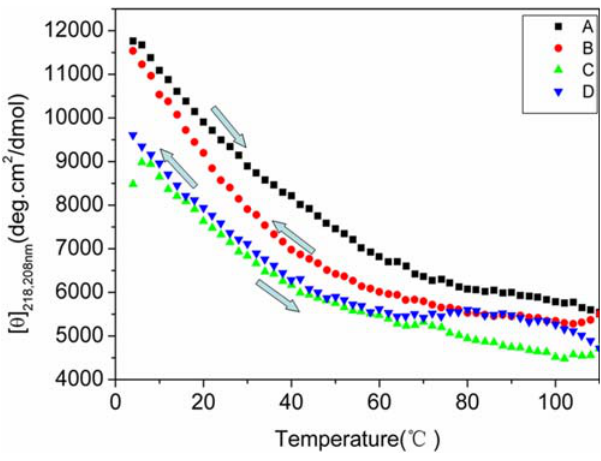
Figure 4. The thermal behavior of d-EAK16. A d-EAK16 peptide sample was measured at 218 nm and 208 nm from 4 u C to 110 u C with incremental 2 u C change. The temperature equilibration time is 30 seconds and averaging time is 1 second. After reaching 110 u C and waiting for 1-minute, the cooling from 110 u C to 4 u C was initiated. The changes of ellipticity from 4 u C to 110 u C and from the 110 to 4 u C were shown. After the temperature cycles, [ h ] 218nm of d-EAK16 decreased , 2%, but increased , 13% at [ h ] 208nm . A and B profiles refer to d-EAK16 ellipticity [ h ] 218nm from 4 u C to 110 u C and back from 110 u C to 4 u C. On the other hand, C and D profiles refer to ellipticity [ h ] 208nm from 4 u C to